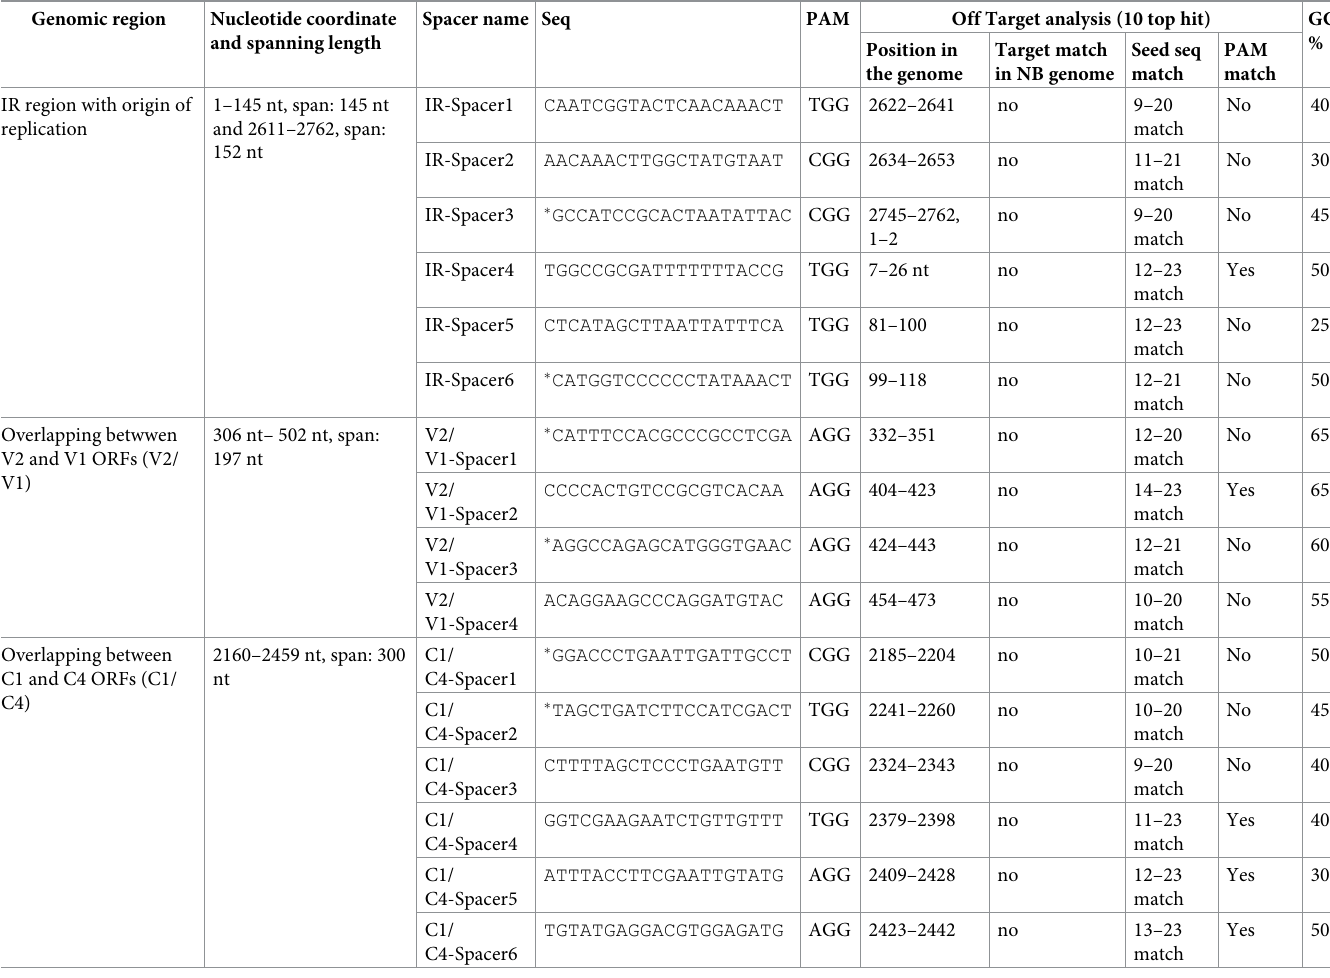
Table 1. Details of spacer sequences selected from chilli leaf curl virus (ChiLCV) genome and their final selection based on off-target analysis and GC%. Genomic region Nucleotide coordinate and spanning